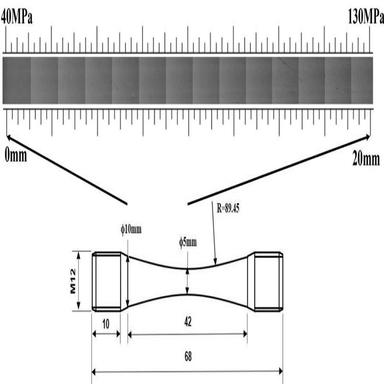
The whole microstructure of arc-section specimen with stress continuously changing from 40 MPa to 130 MPa.